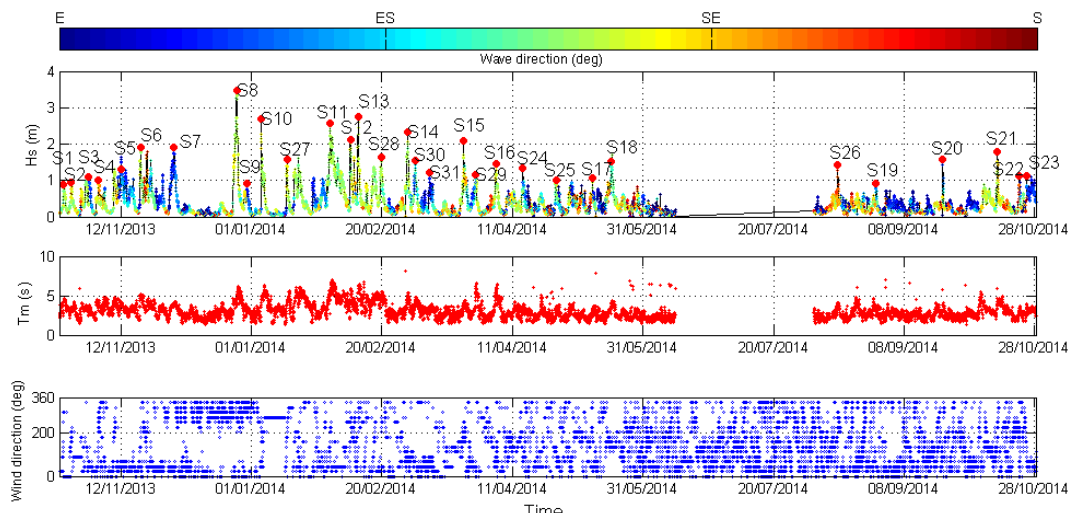
Figure 2. Time series of wave height ( H s ), wave period ( T m ) and wind direction in the analysed period.